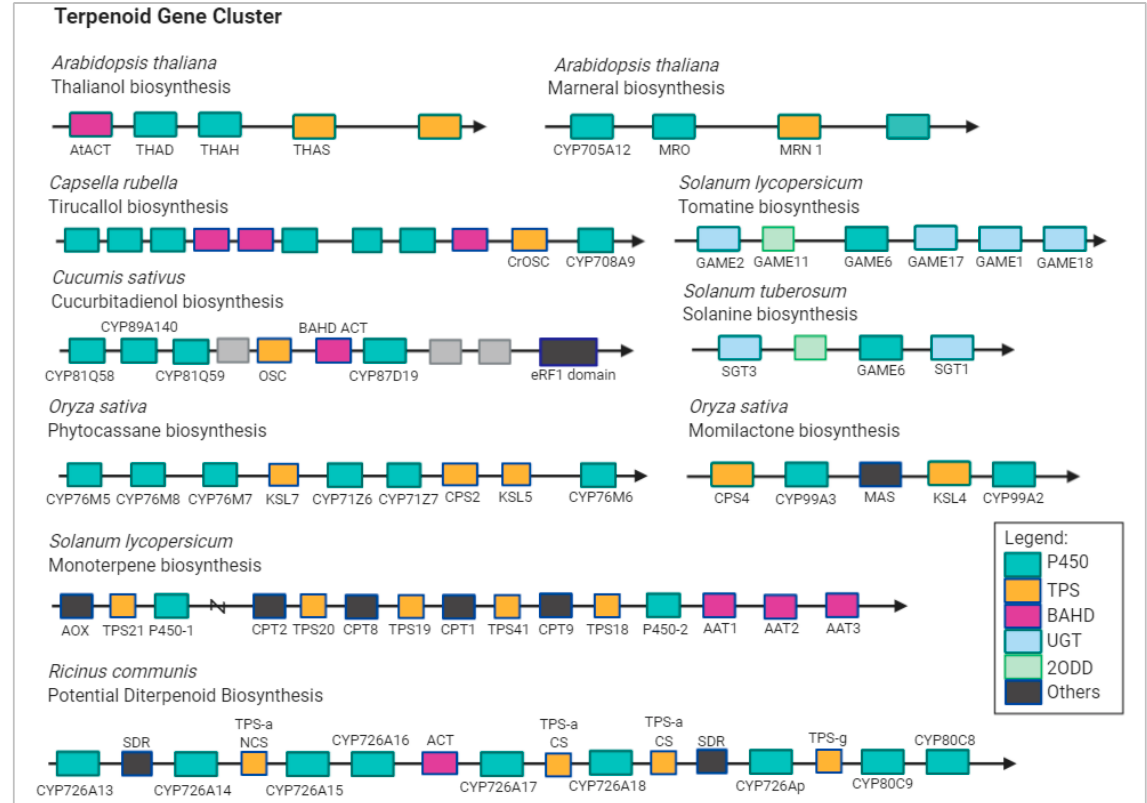
Figure 3. Terpenoid biosynthetic gene cluster in plant genomes. Abbreviations: AAT, alcohol acyl transferases; ACT, acyltransferase; AOX, aldehyde oxidase; CPS, labdadienyl/copalyl synthases; CS, casbene synthase; KSL, kaurene synthase-like gene; MAS, momilactone A synthase; THAH, thalianol hydroxylase; THAS, thalianol synthase; MRO, putative marneral oxidase; MRN, marneral synthase; OSC, oxidosqualene synthase; GAME, glycoalkaloid metabolism; SGT, sterol alkaloid glycosyltransferase; TPS, terpene synthase; P450, CYP; NCS, neo-cembrene synthase; SDR, short-chain alcohol dehydrogenase/reductase; 2ODD, 2-oxoglutarate-dependent dioxygenase; UGT, UDP-sugar dependent glycosyltransferase family.